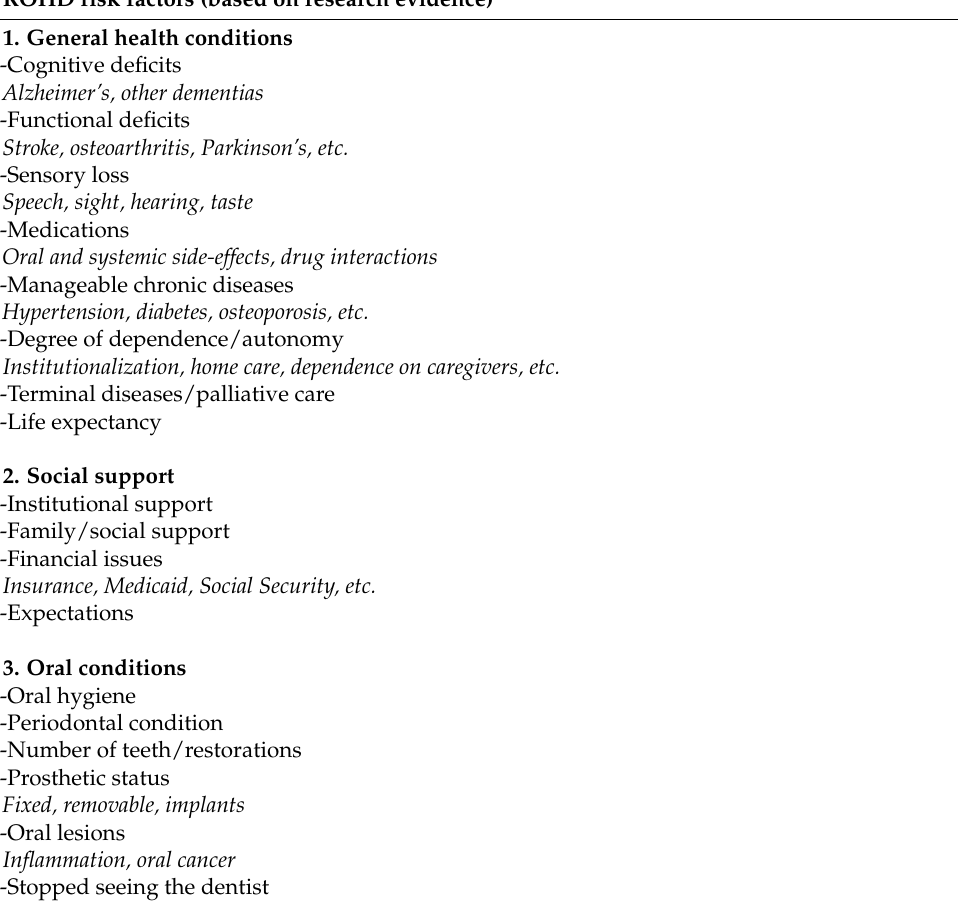
Table 1. Summary of ROHD risk factors, its risk categories, and potential treatment